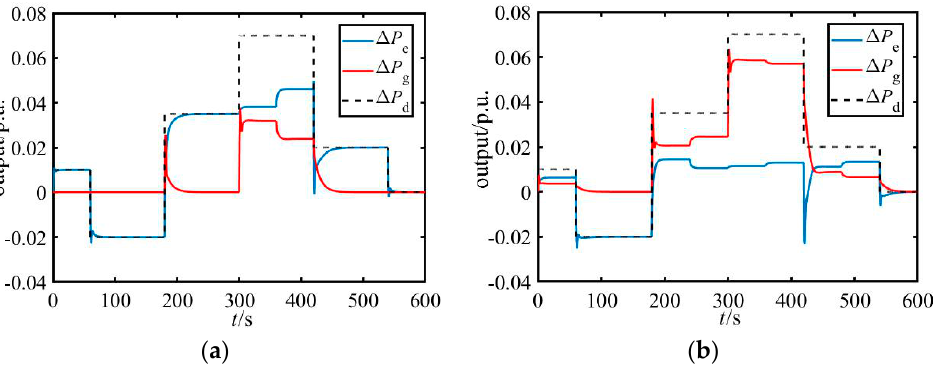
Figure 9. Synergetic output of wind power and thermal power for frequency regulation. ( a ) High wind speed. ( b ) Low wind speed.